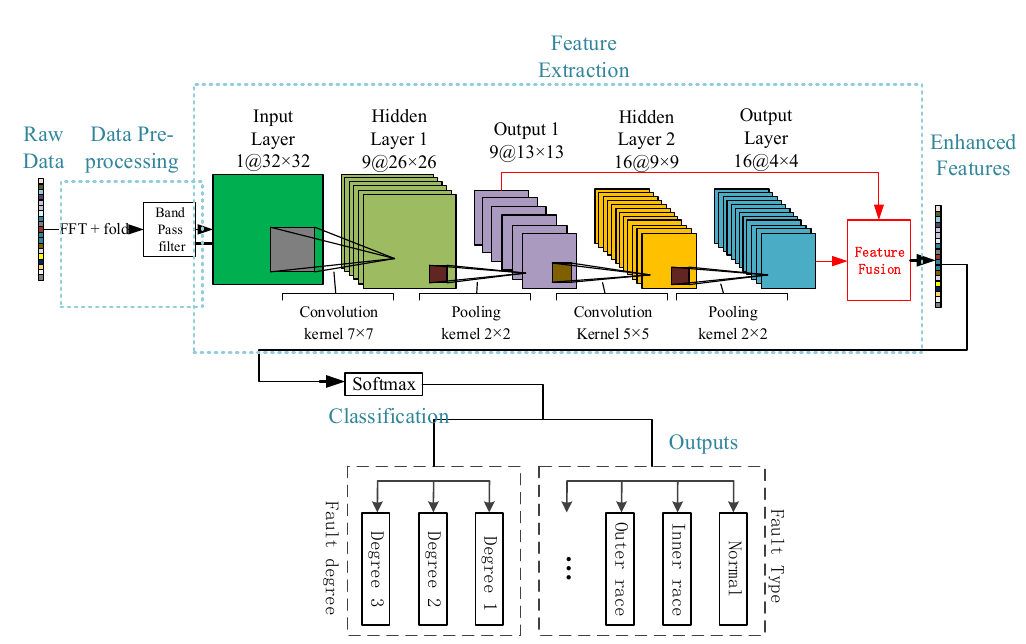
Figure 5. Bearing fault diagnosis model based on an improved convolutional deep belief network (CDBN). FFT; fast Fourier transform. Table 1. Specific parameters of the network.